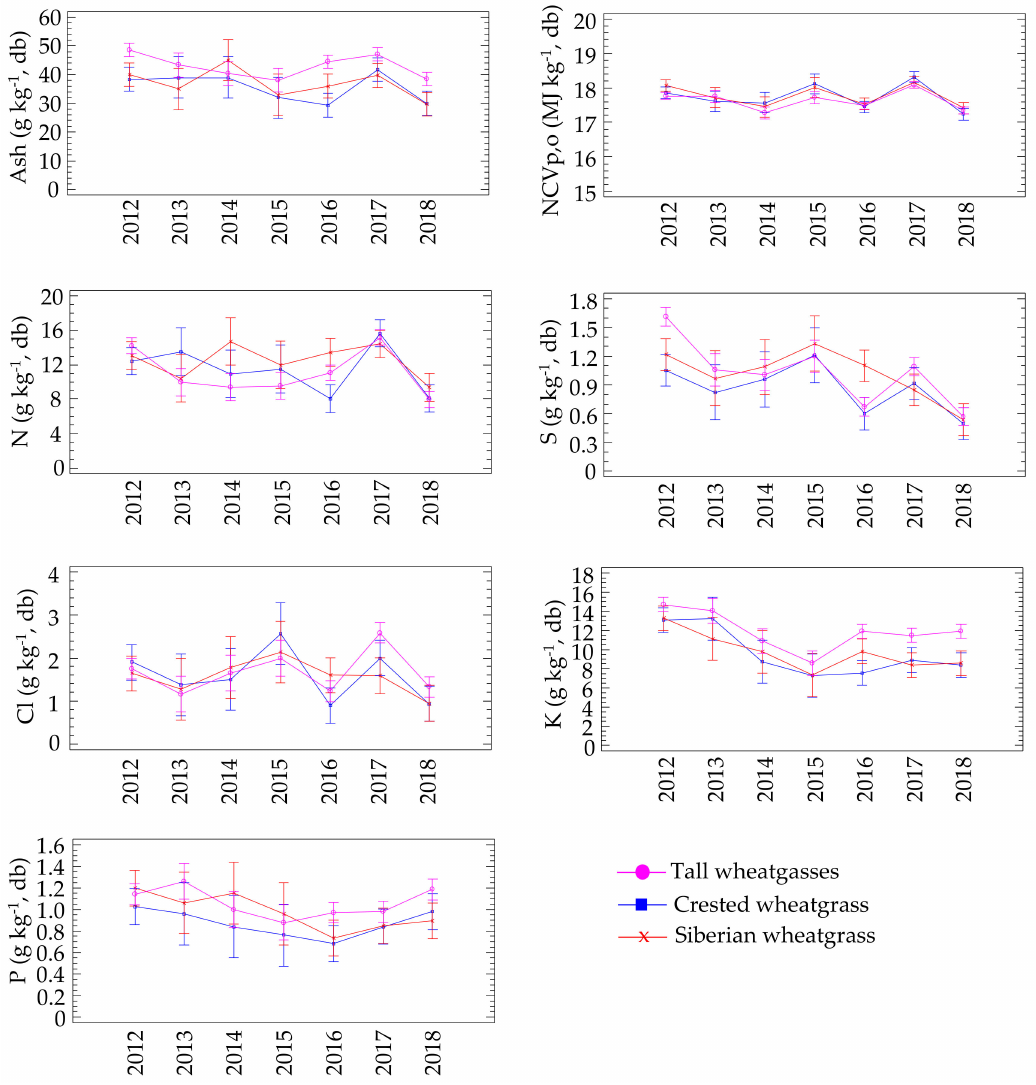
Figure 3. Net calorific value, ash, N, P, K, S, and Cl contents across species and years for the biomass cultivated in CS fields. Means and Fisher´s LSD interaction